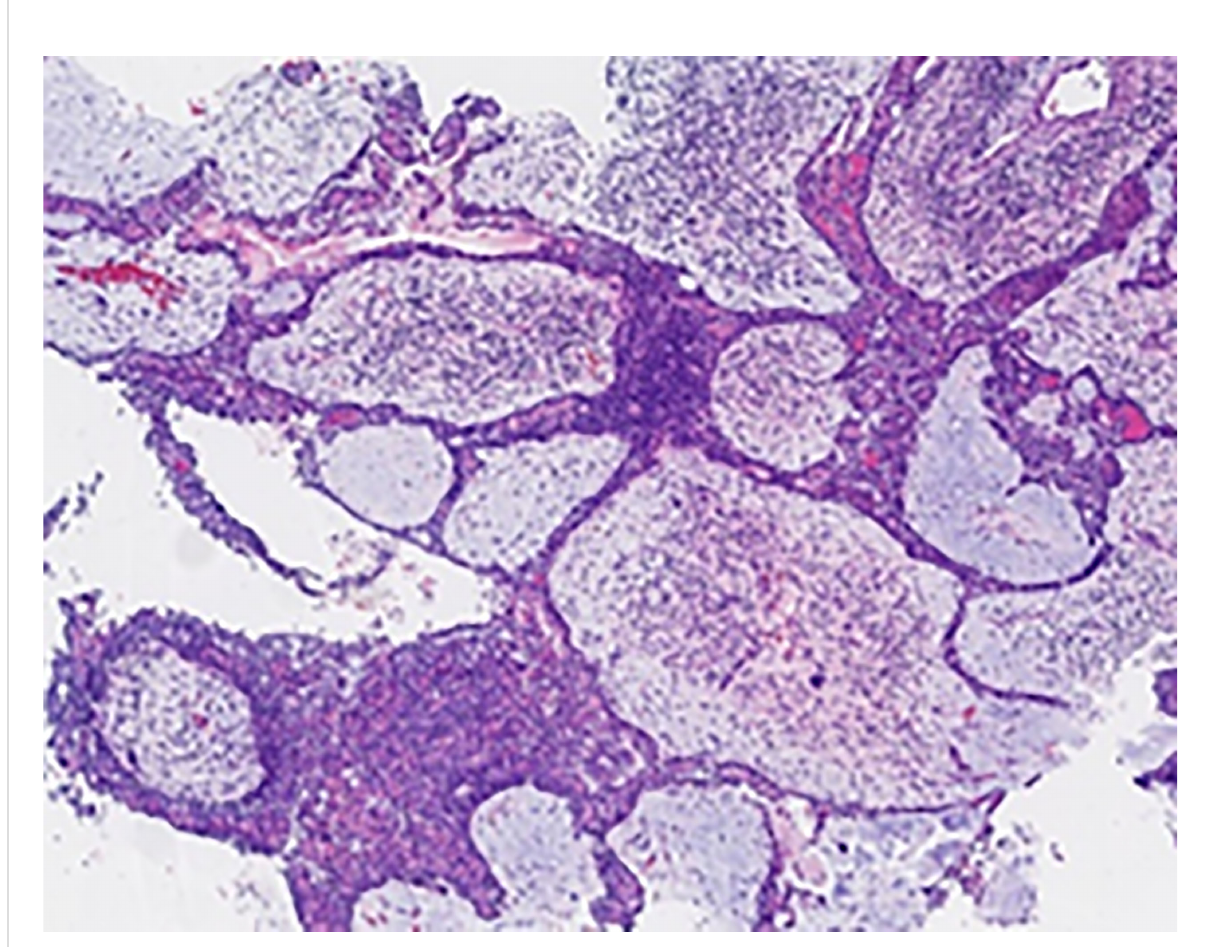
FIGURE 7 Pathological fi ndings of the nasopharyngeal biopsy obtained on 12 January 2022. Nasopharyngeal EMCa recurrence was considered. H&E staining; magni fi cation, ×4. EMCa, epithelial – myoepithelial carcinoma; H&E, hematoxylin and